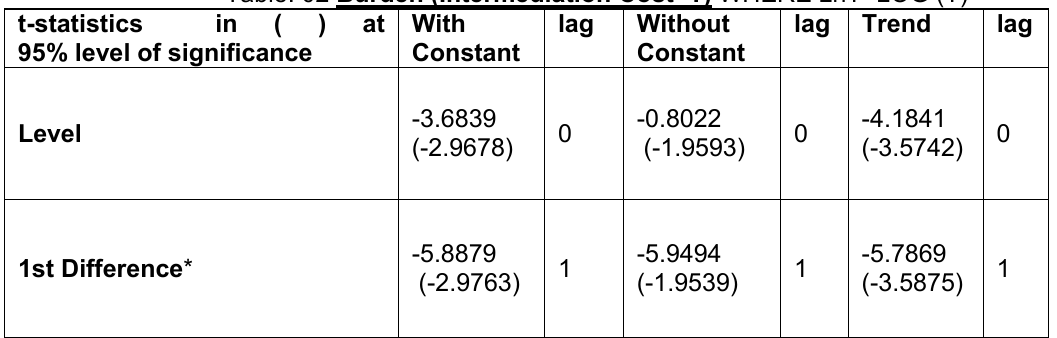
Table: 02 Burden (Intermediation Cost=T) WHERE LnT=LOG (T)